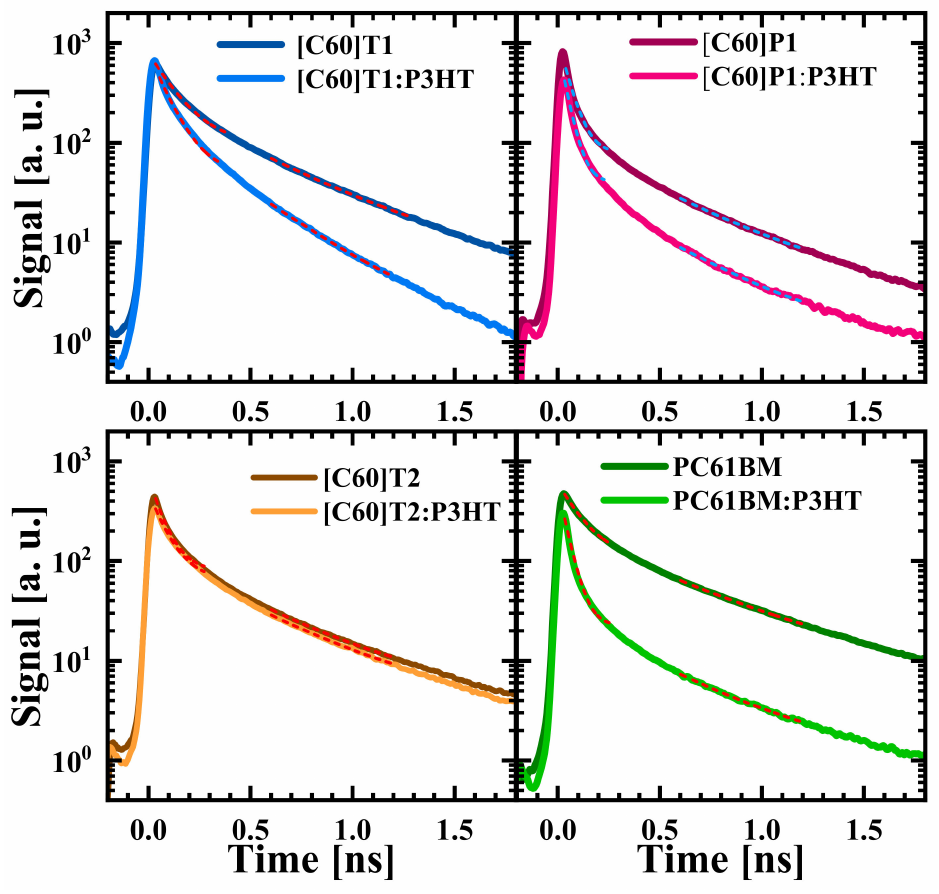
Figure 9. PL signal of the studied fullerene derivatives as integrated in the energy range of 1.54–1.8 eV for pure fullerenes and for fullerene–P3HT blends. The fits with single exponential decays are depicted with dashed